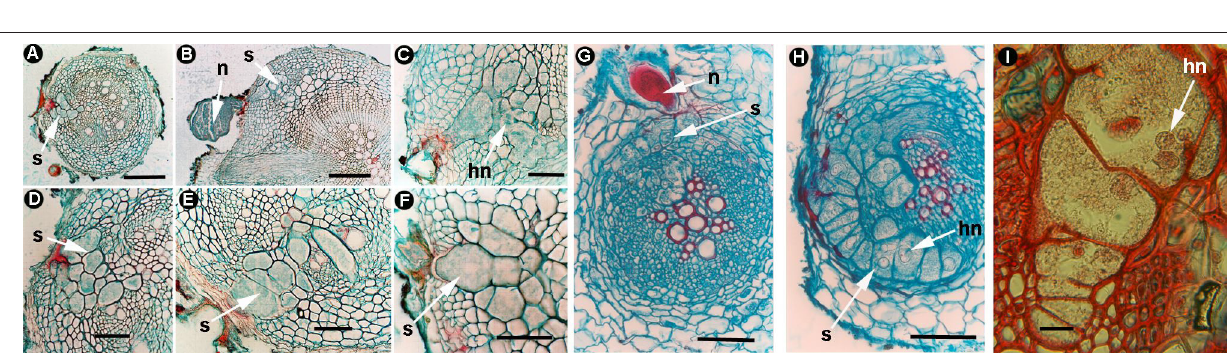
( Figure 4 ; Sobczak and Golinowski, 2011). In Arabidopsis , females of Heterodera schachtii usually develop in syncytia from procambial or pericycle cells, whereas males develop in syncytia